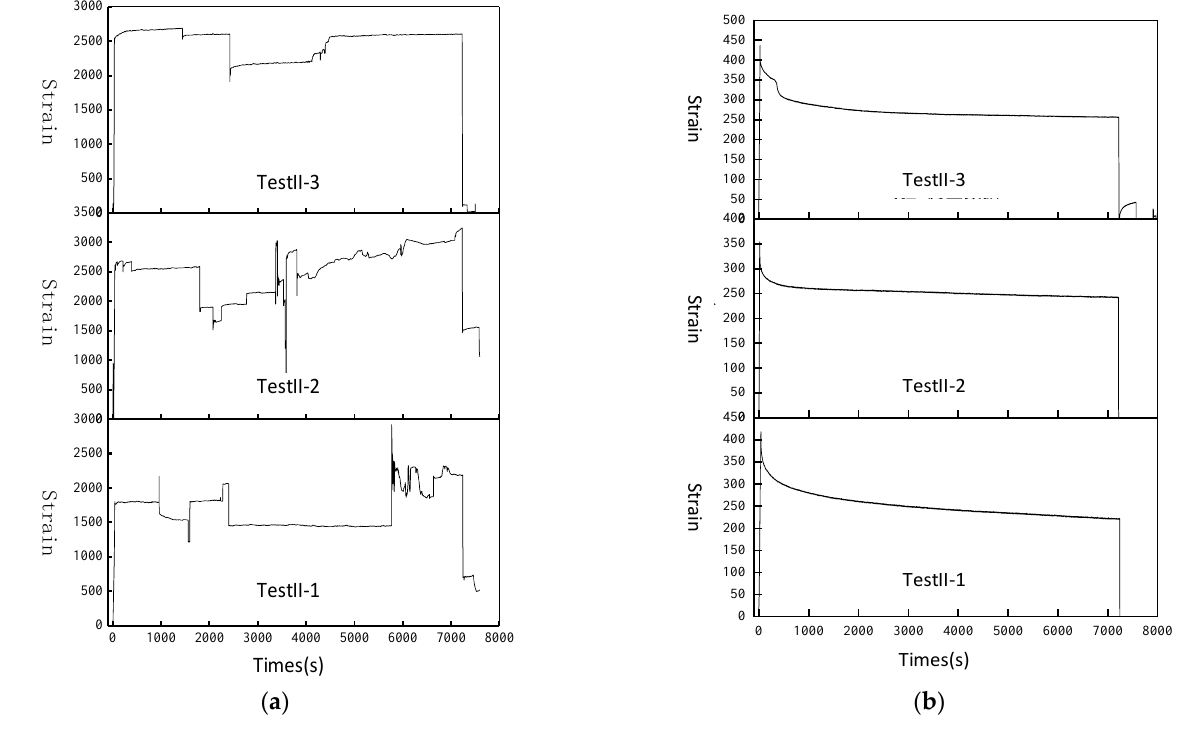
Figure 12. Variation curve of the specimen strain with time under the long-time constant loads. ( a ) The measurement results of the resistance strain gauge sensors; ( b ) the measurement results of the FBG sensors.